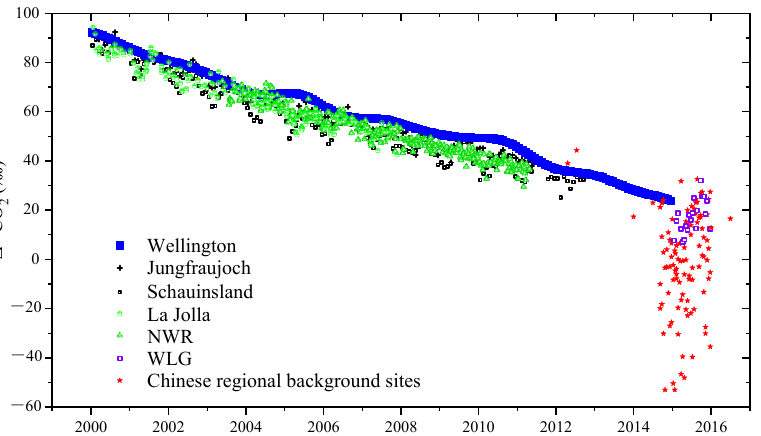
Figure 1. ∆ 14 CO 2 measurements of background sites. Blue square: Wellington, Newzealand [52]; black cross: Jungfraujoch, black box: Schauinsland, Europe [53]; semi-filled green circle: La Jolla, green triangle: Niwot Ridge, North America [54–56]; purple box: Waliguan, China [57,58]; other red symbols: regional background sites in China, Shangdianzi, Luhuitou, Li’an, Longfengshan